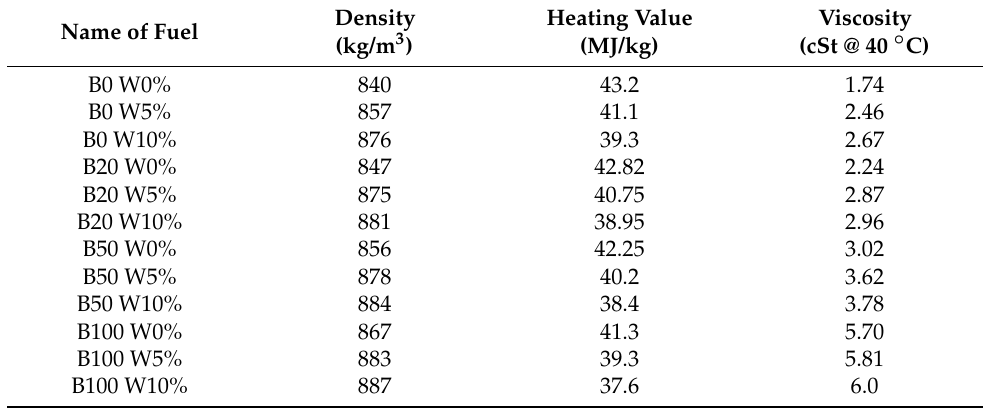
Table 5. Properties of Emulsified